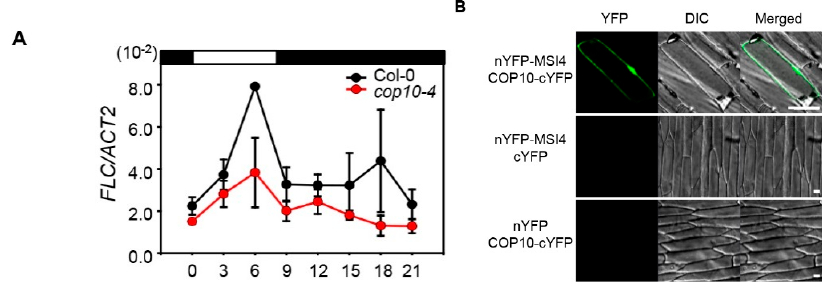
Figure 6. COP10 regulates FLOWERING LOCUS C ( FLC ) expression through interaction with MULTICOPY SUPPRESSOR OF IRA1 4 (MSI4)/FVE (MSI4/FVE). ( A ) The expression of FLC analyzed in Col-0 and cop10-4 mutants by real-time PCR using three-week-old plants. Plants were grown at 22 °C under SD (8-h light:16-h dark) conditions, and plant tissues were harvested every 3 h. ACT2 expression was used for normalization. Means and standard deviations were obtained from three biological replicates. ZT, zeitgeber time (h after dawn); ( B ) COP10 interacts with MSI4 in plants. BiFC analysis of the interaction between MSI4 and COP10 in onion epidermal cells. nYFP-ELF3 and cYFP-ELF4 plasmids served as a positive control [21]. For the negative controls, empty nYFP-GI/cYFP and nYFP/cYFP-COP10 were used. Each pair of recombinant plasmids encoding nYFP and cYFP fusions was mixed 1:1 ( w / w ) and co-bombarded into onion epidermal cell layers. The transformed onion epidermal layers were incubated at 22 °C for 16–24 h under light conditions. YFP fluorescence was indicated by green color. Each bar indicates 50 μ m. DIC, differential interference contrast. These experiments were repeated three times with the same results.